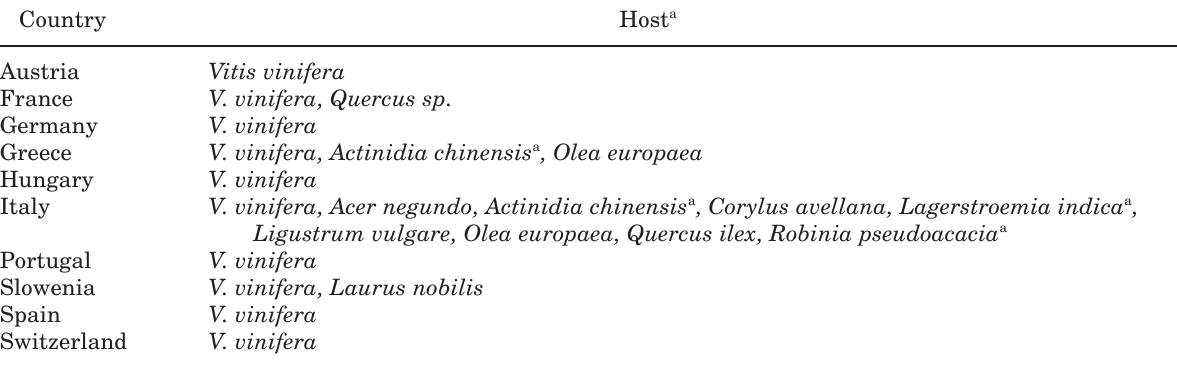
Table 1. Geographic distribution and host range of Fomitiporia mediterranea in Europe. Country Host